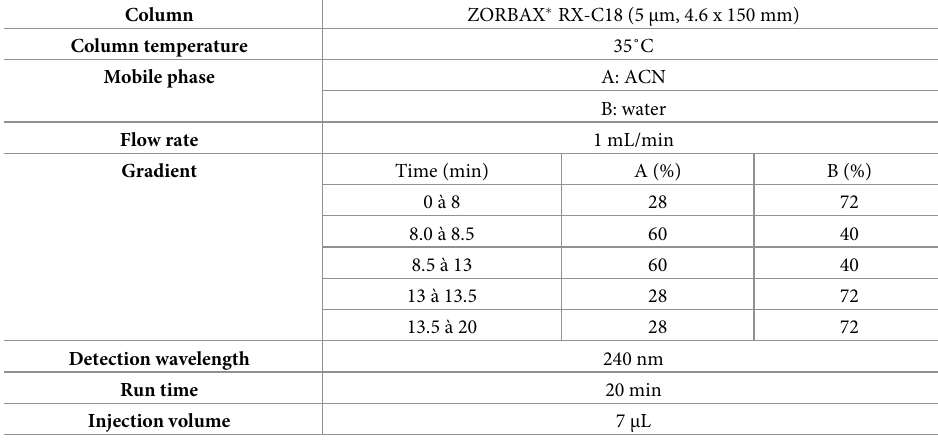
Table 1. Chromatographic conditions for the quantification of hydroxyurea.